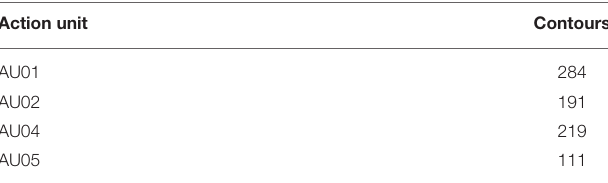
TABLE 5 | Number of usable contour pairs for each Action